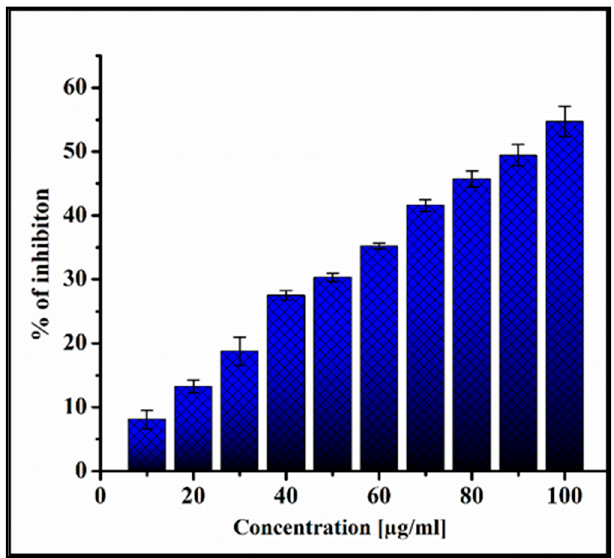
Figure 10. Cell proliferation analysis by MTT assay. Different concentrations of PoAgNPs (0 to 100 µg/mL) were used to treat MB-MDA-231 cancer cell lines. The proliferation rates were expressed as mean ± SD of the three experiments.